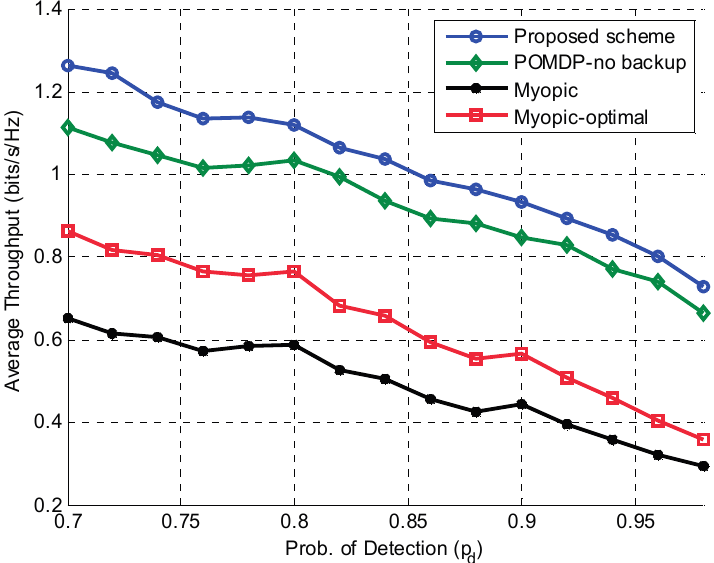
Figure 5. Average throughput comparison of our proposed scheme with POMDP–no backup, Myopic, and Myopic-optimal schemes for different values of (cid:1842)